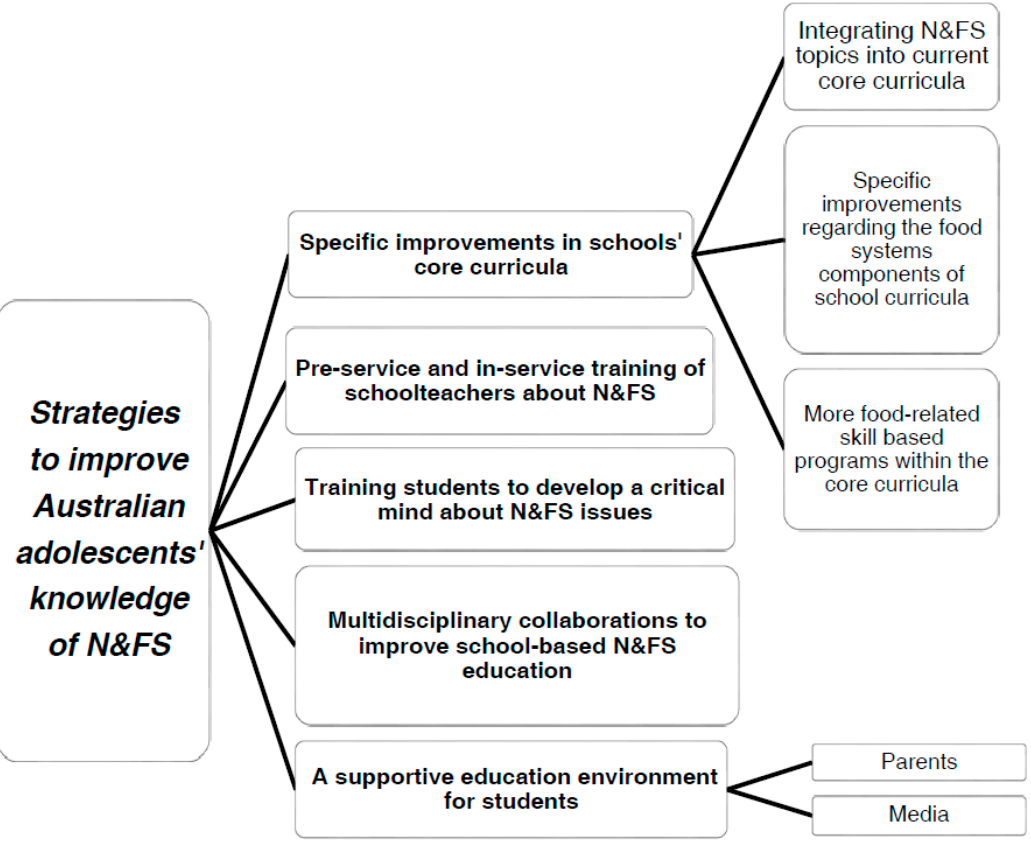
Figure 1. Professionals’ recommended strategies to improve Australian adolescents’ knowledge of nutrition and food systems (N&FS).